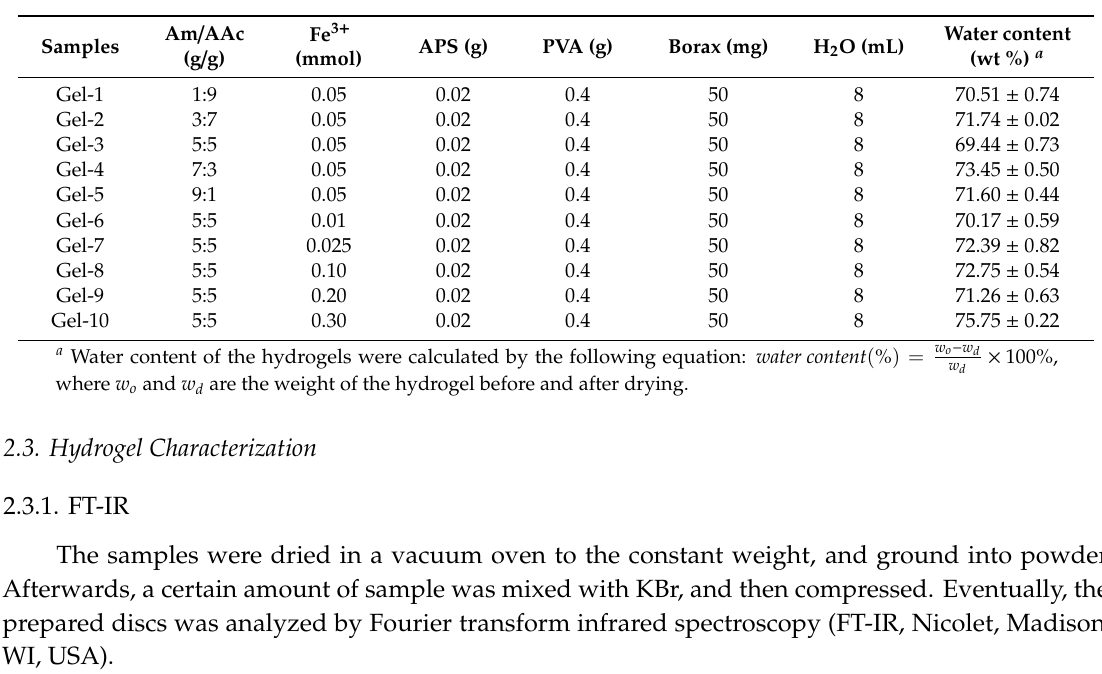
Table 1. P(AAc- co -Am) / PVA double network hydrogels with various